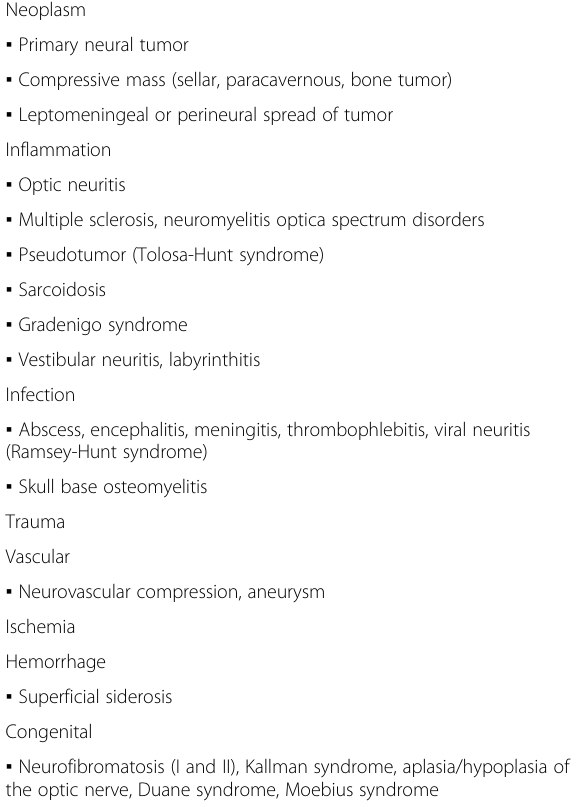
Table 5 Summary of pathologies that may involve cranial nerves